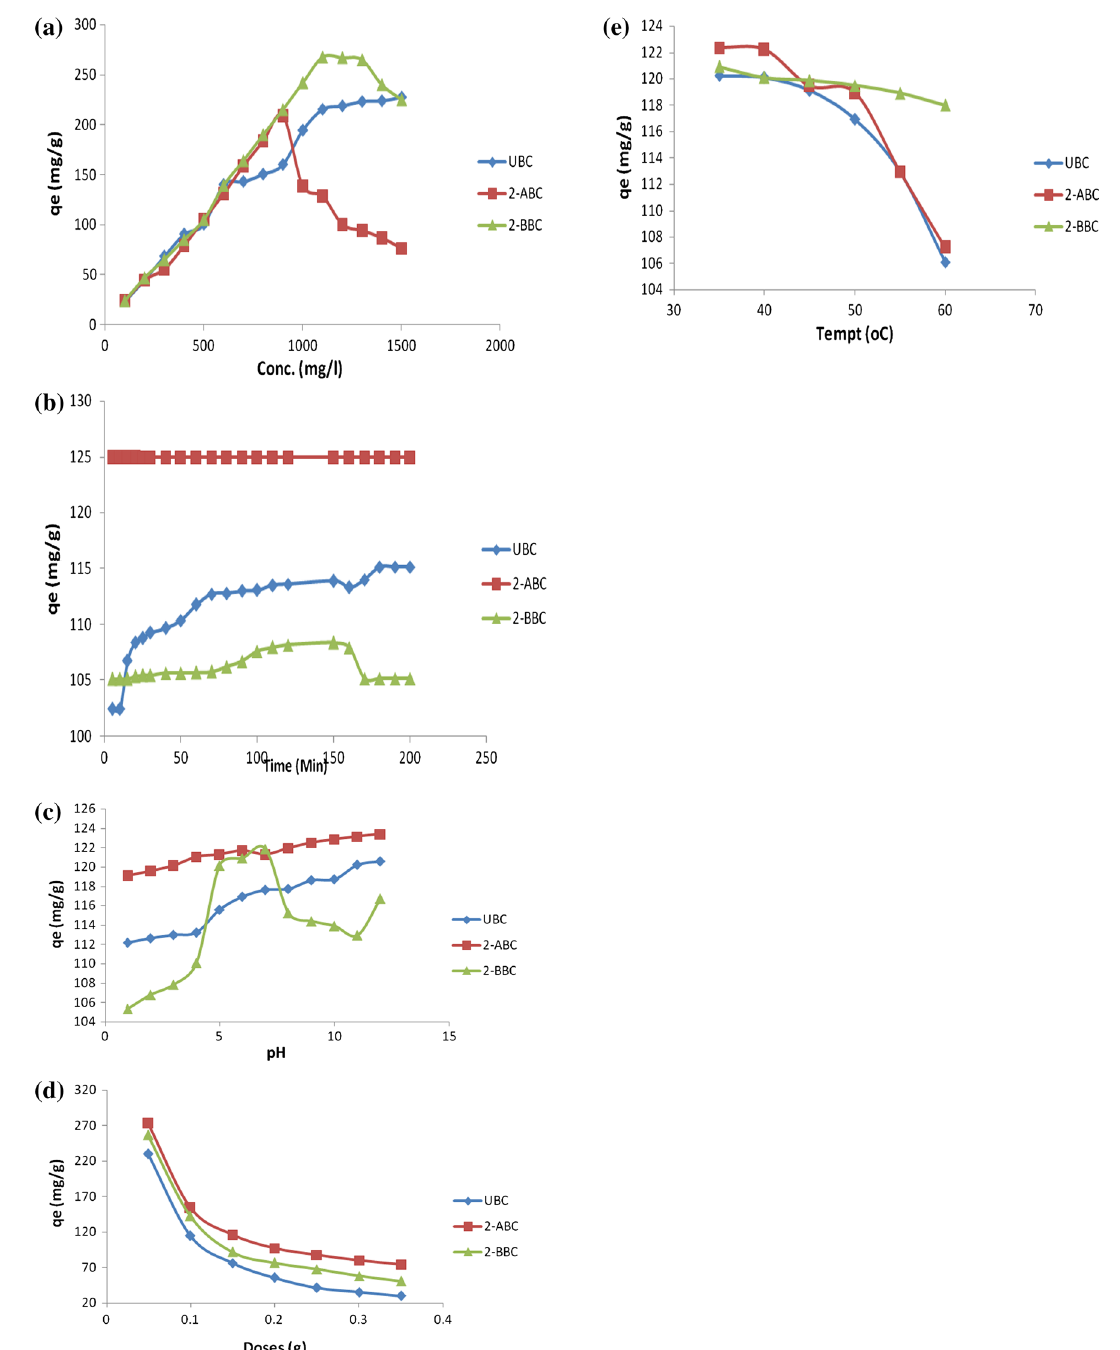
Fig. 5 Effect of adsorption conditions on adsorption capacities of the active carbons. a Initial concentration; b contact time; c pH; d adsorbent dosage; e